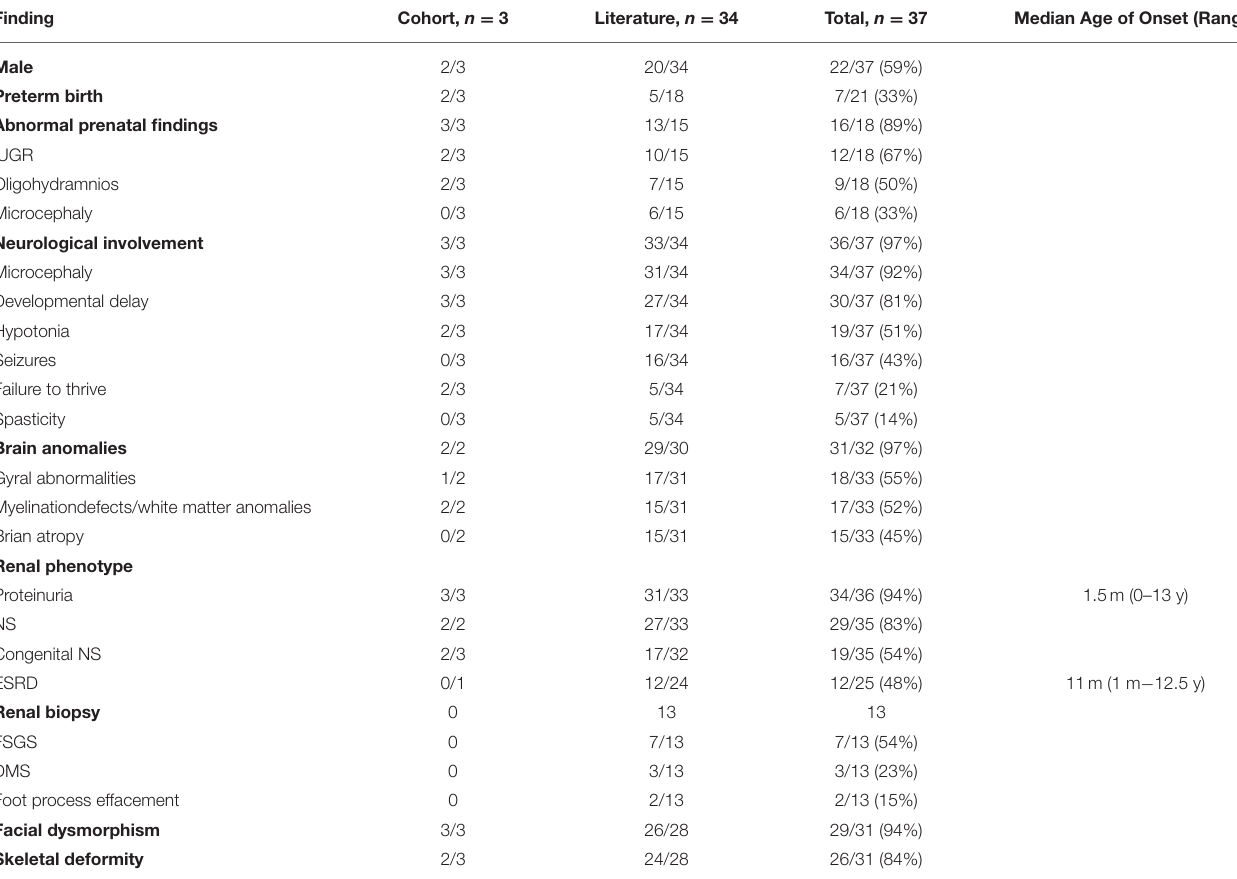
TABLE 1 | Clinical features of 37 patients with Galloway-Mowat syndrome type